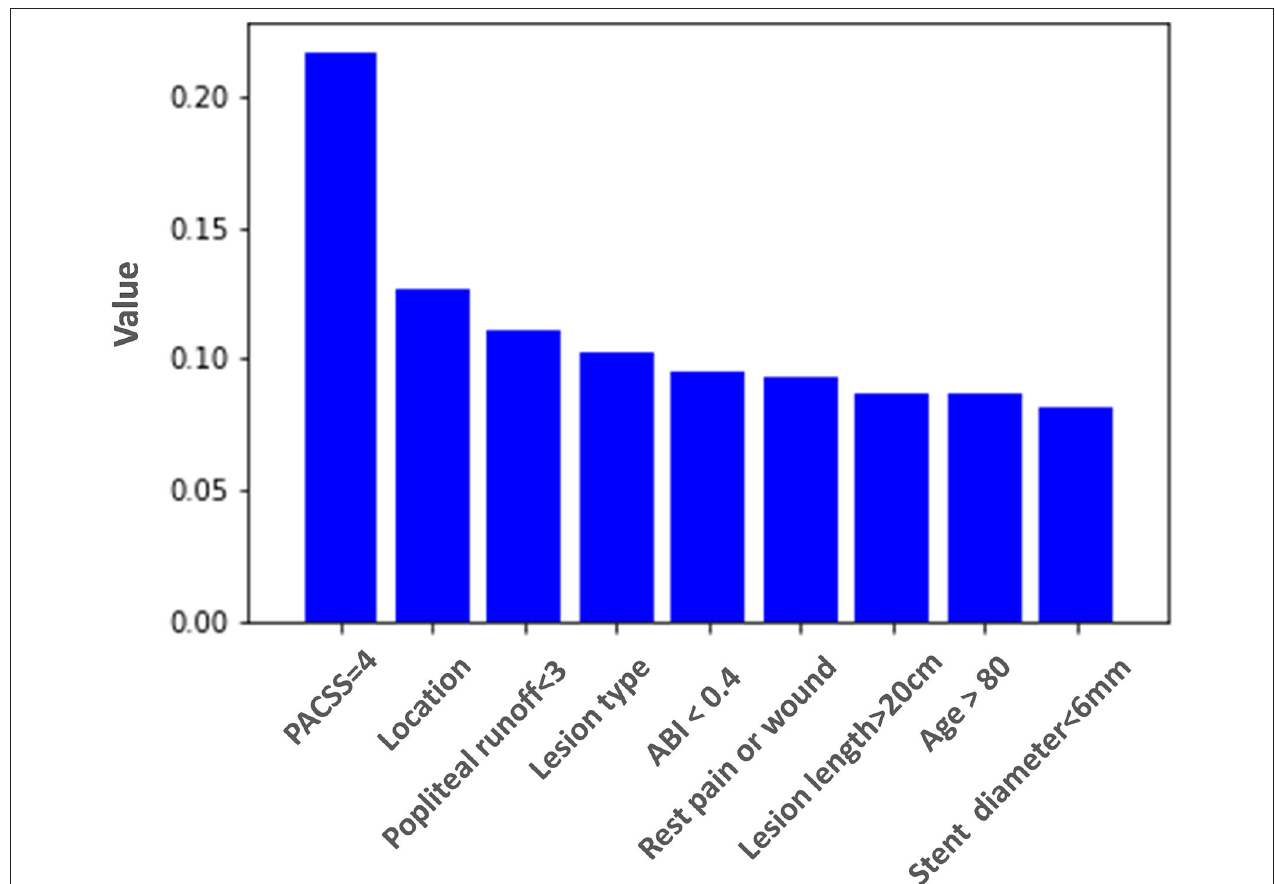
FIGURE 4 | Importance ranking of variables used in the random forest model for prediction of 2-year major adverse limb event-free survival. PACSS, peripheral arterial calcium scoring system; ABI, ankle-brachial